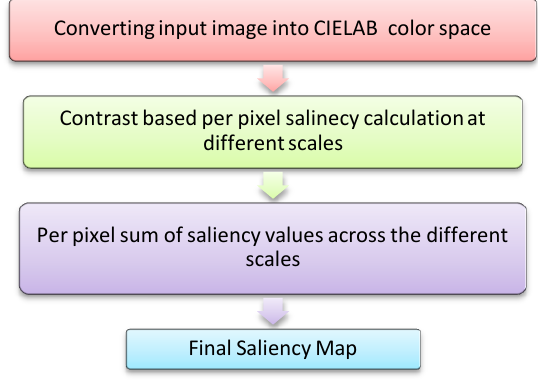
Figure 3. Work Flow diagram of Saliency by Low level Feature Contrast